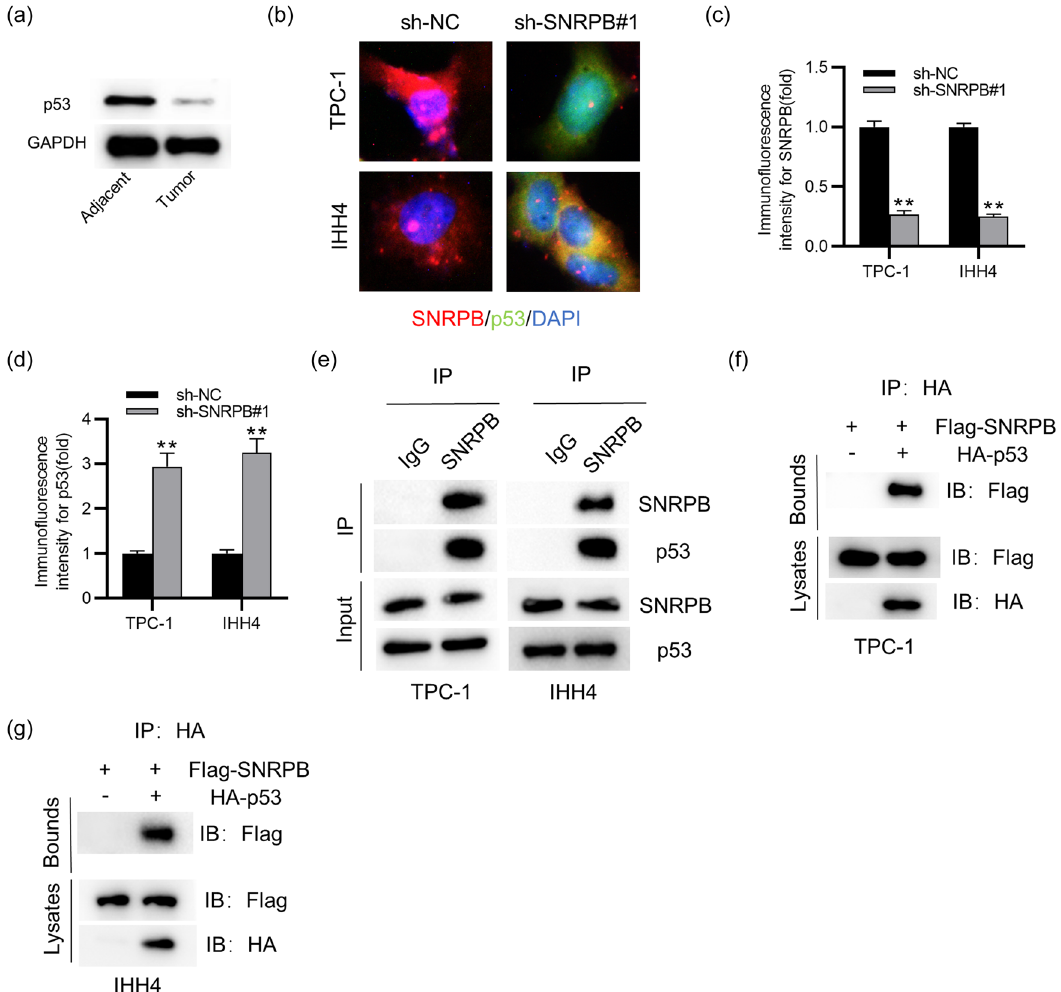
Figure 4: SNRPB inhibits p53 expression: ( a ) western blotting of p53 protein level in PTC tissues and adjacent normal tissues, ( b ) IF staining for detecting expression of SNRPB and p53 in sh - NC - or sh - SNRPB#1 - transfected PTC cells, ( c and d ) quanti fi cation of IF intensity of SNRPB and p53 and ( e – g ) Co - IP for determining the interaction between p53 and SNRPB in PTC cells. Student ’ s t - test was performed for statistical analysis. ** p <